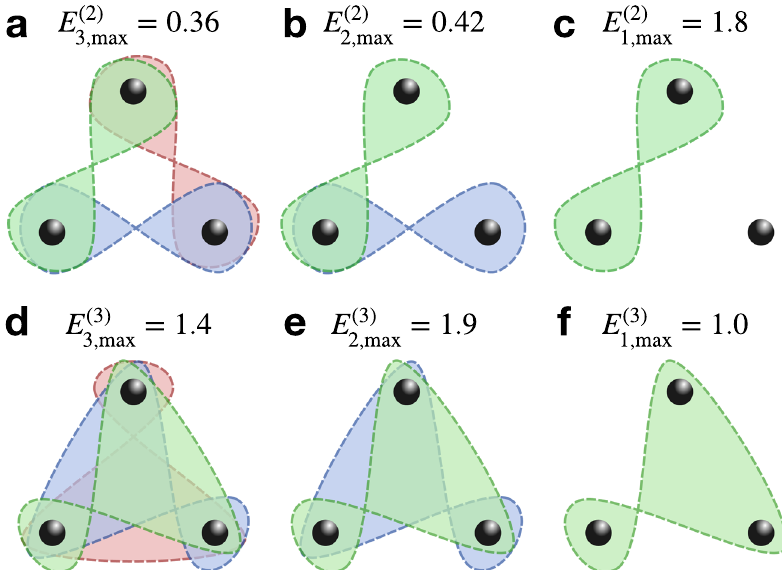
Fig. 2 Entanglement structure in a three-particle system. Dyadic entanglement (between two particles with the third particle traced out) can be observed in a all three pairs, b two pairs, or c one pair. Triadic entanglement (in the full three-particle covariance matrix with one bipartition containing one particle and the other bipartition consisting of the remaining two particles) can be observed in d all three bipartitions, corresponding to genuine tripartite entanglement, e two bipartitions, or f one bipartition. For each con fi guration, the maximum achievable entanglement (as quanti fi ed by logarithmic negativity) is shown (for assumed experimental parameters, see the caption of Fig. 3). The case of all three bipartitions separable is not